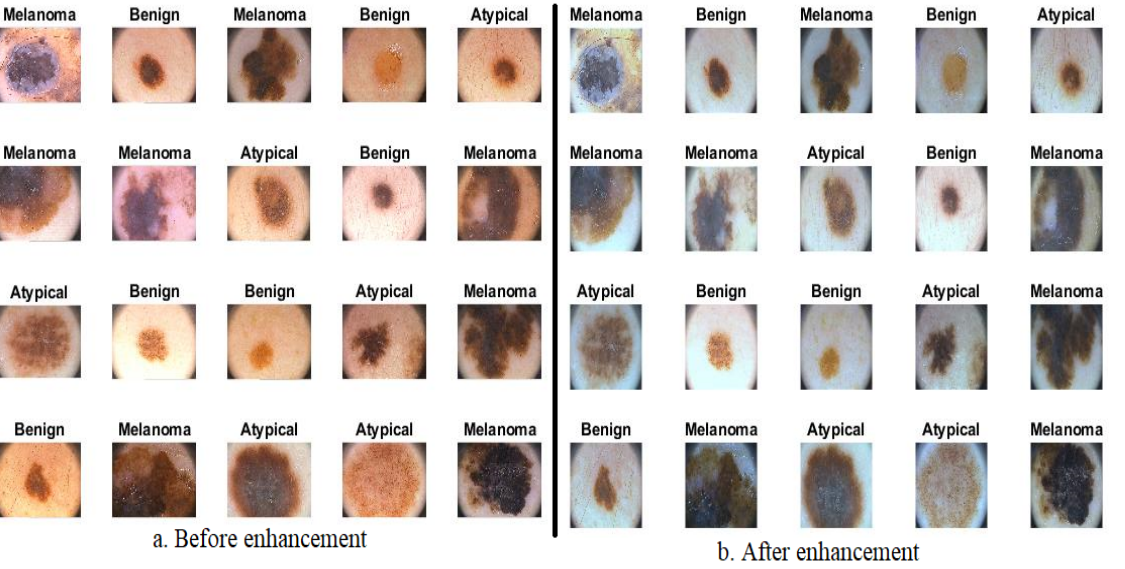
Figure 3. Samples of dermoscopic images for all classes of the PH2 data set ( a ) before enhancement and ( b ) after enhancement.